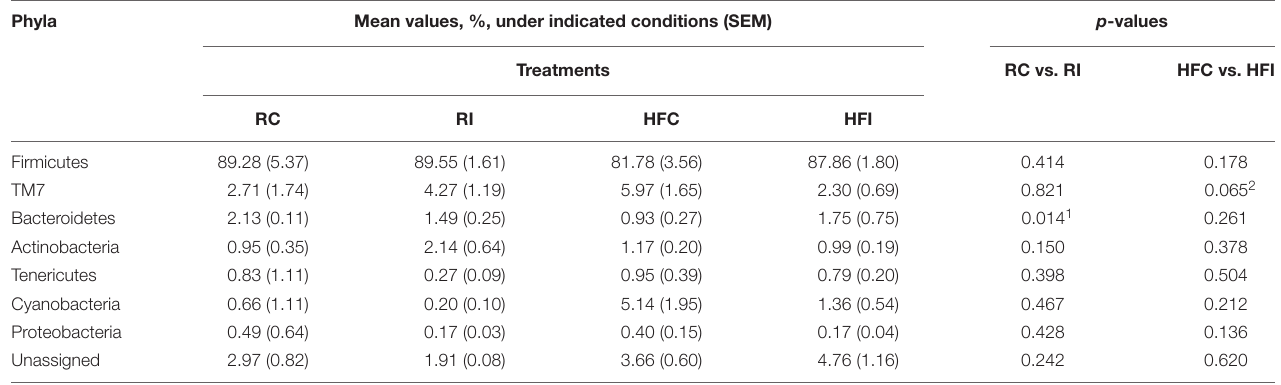
TABLE 4 | Average percentage of bacteria phyla in the sacculus rotundus samples. Phyla Mean values, %, under indicated conditions (SEM) p -values Treatments RC vs. RI HFC vs. HFI